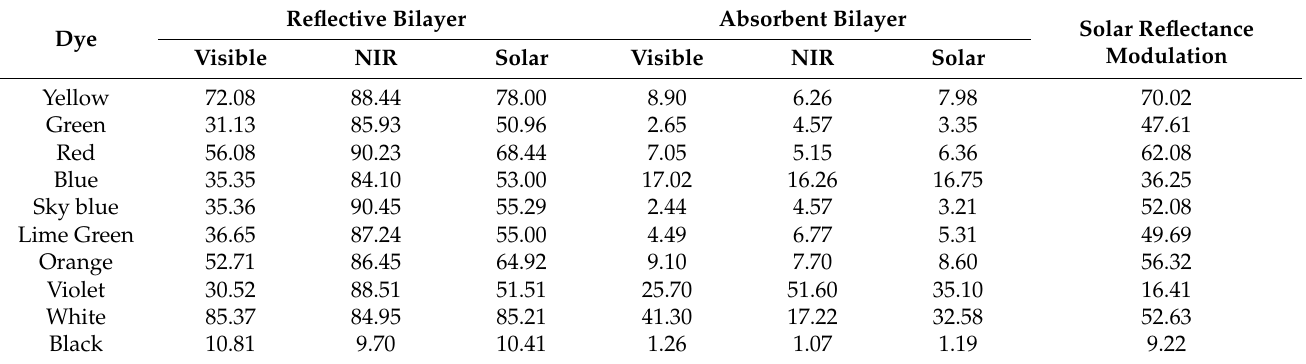
Table 1. Reflectance values of the studied bilayers in the visible, NIR and solar range both in their absorbent and reflective compositions.